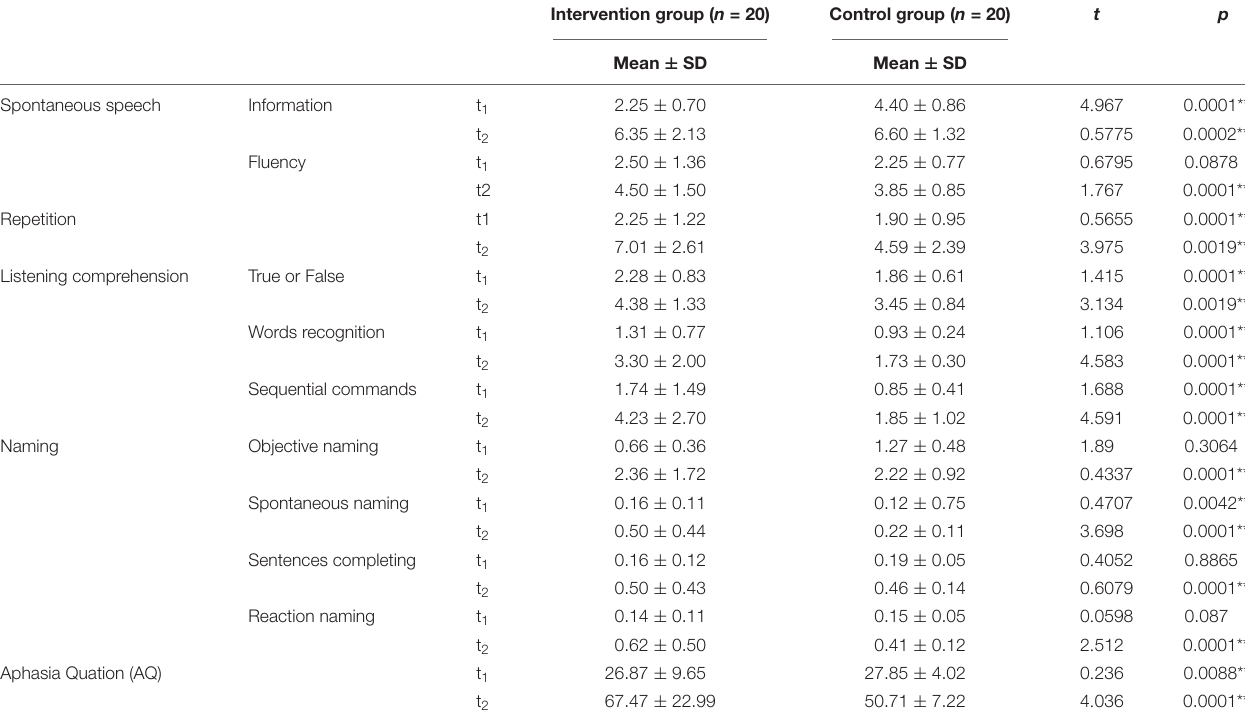
TABLE 2 | The results of Boston Diagnosis Aphasia Examination (BDAE) in patients with non-fluent aphasia across the study period for the intervention group and the control group.